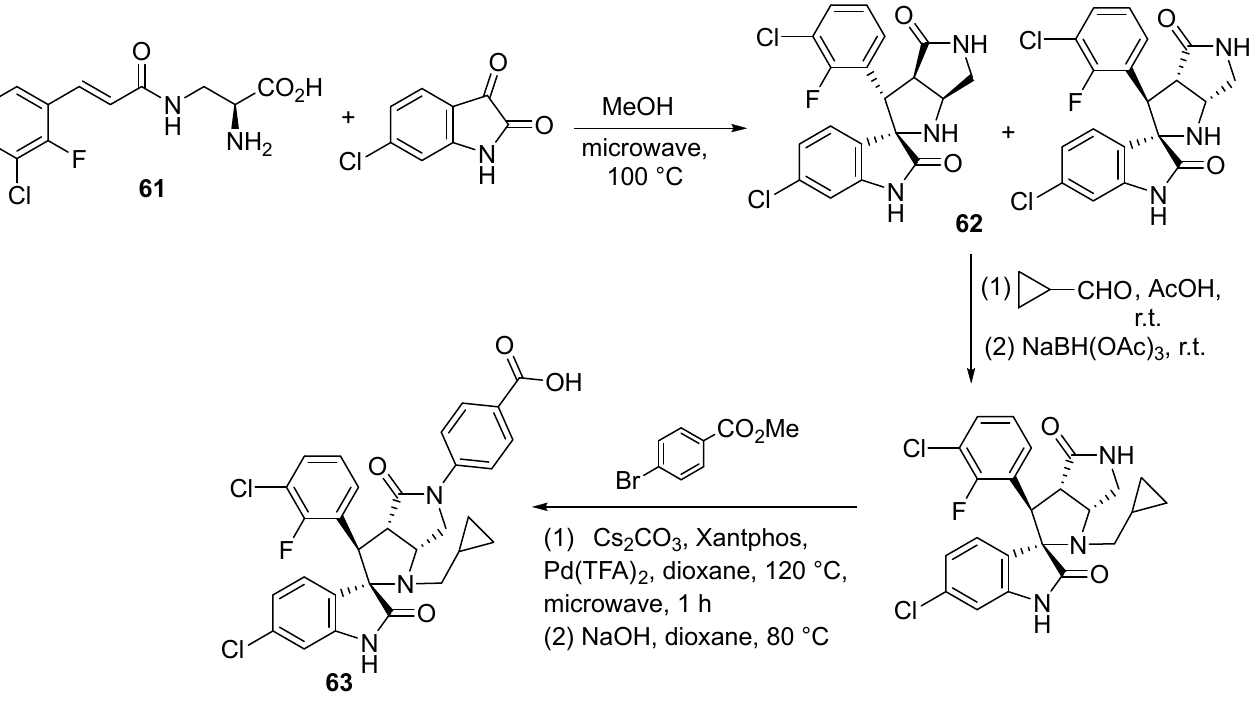
Figure 8. MDM2-p53 inhibitors entered in human clinical trials. Azomethine cycloaddition derived from amino acid derivative 61 in MeOH under microwave irradiation at 100 °C with isatin afforded the spirooxindole derivative 62 as a